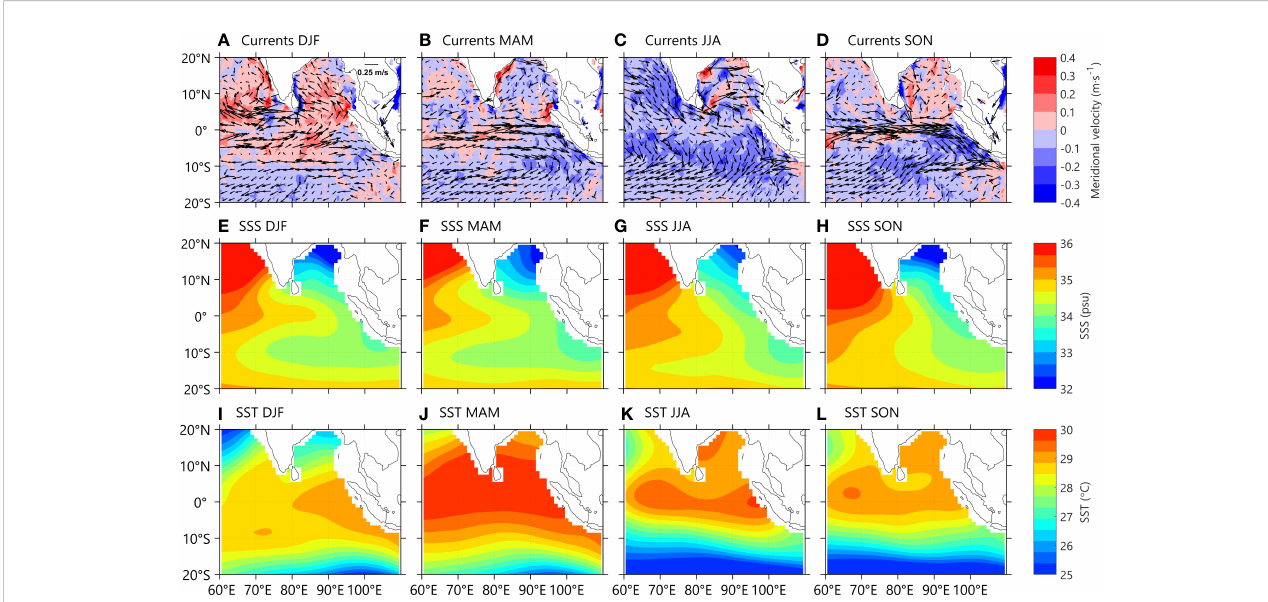
FIGURE 1 Seasonal distribution of (A – D) currents (arrows), meridional velocity (shading), (E – H) SSS, and (I – L) SST provided by the drifter-derived currents and Argo data. The seasons are winter (DJF, December- February), spring (MAM, March-May), summer (JJA, June-August), and fall (SON, September-November),